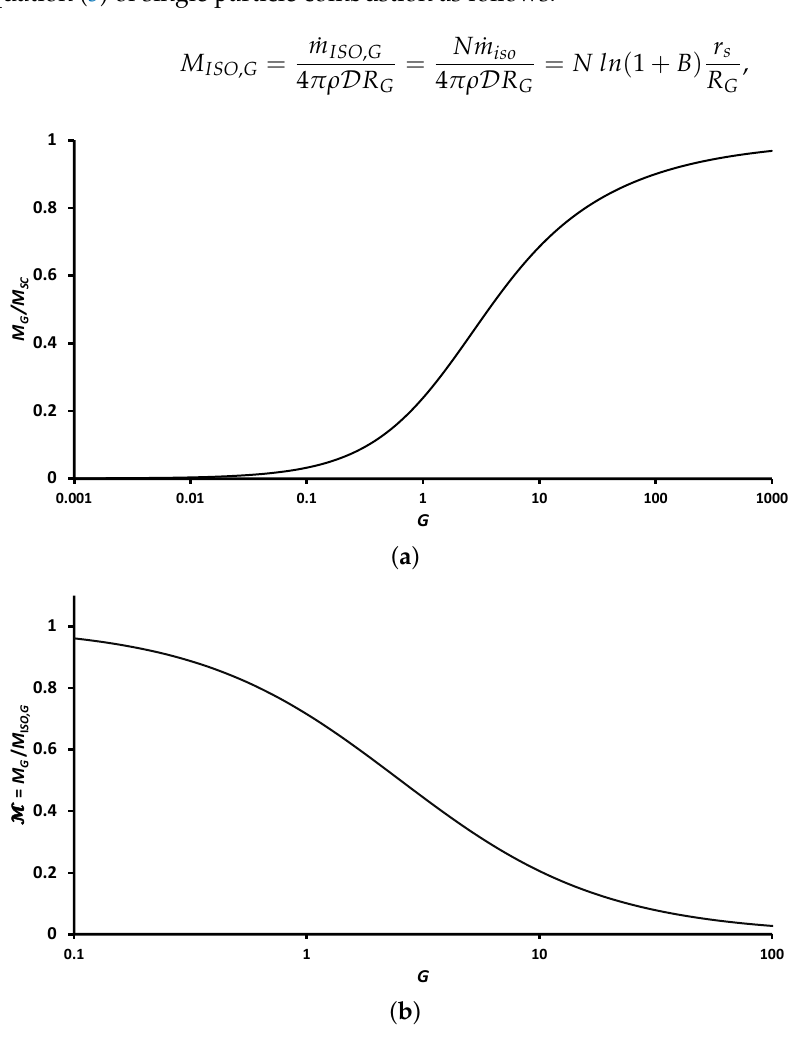
Figure 6. ( a ) The fraction variation of cloud combustion rate to sheath combustion for a spherical nanothermite group with group combustion number. ( b ) The fraction variation of cloud combustion rate to isolated individual particle combustion for a spherical nanothermite